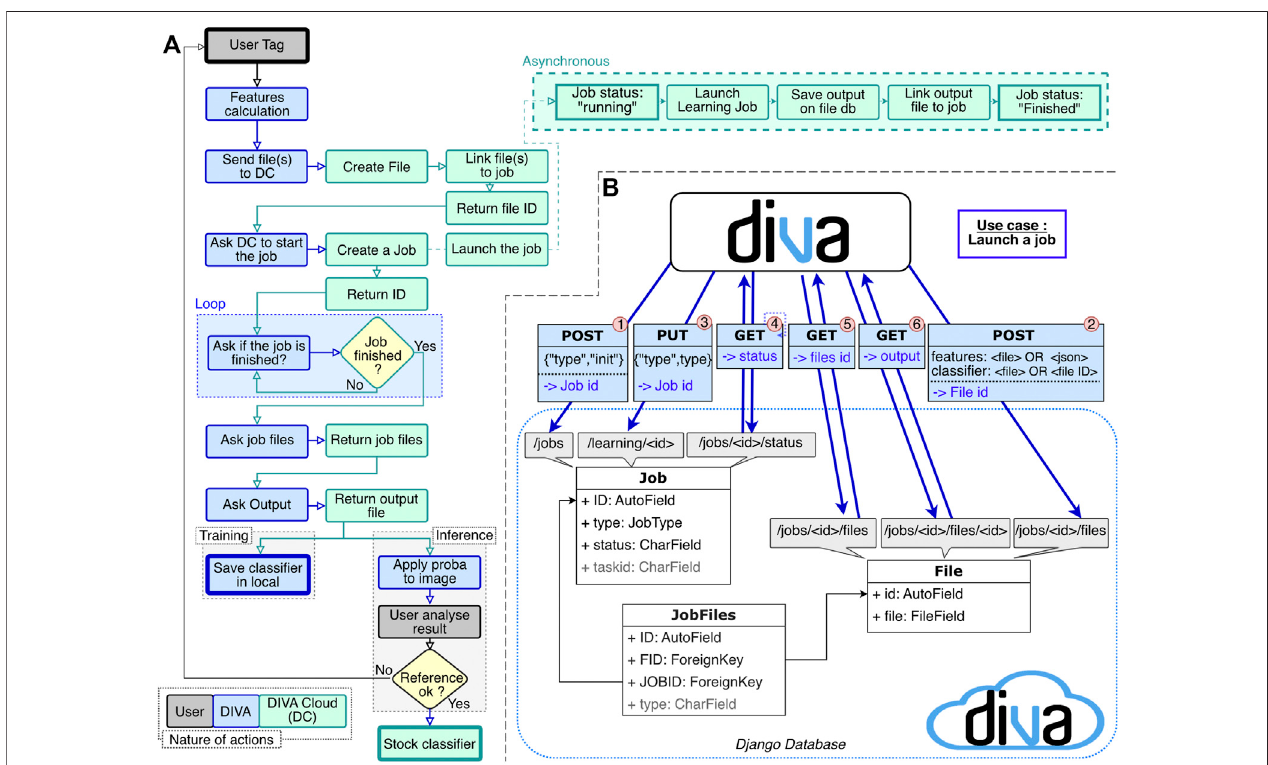
FIGURE4|(A) DIVACloudinteractionwork fl owthroughadatataggingexperimenttooutputaclassi fi erthatisvisualizedinDIVA. (B) InteractionbetweenDIVAand DIVACloudin6steps:1)POSTrequesttothe/jobsendpoint.ItinitializesajobentryinDjango.GetinreturnthejobID2)POSTrequesttothe/jobs/ jobid / fi leendpointwith